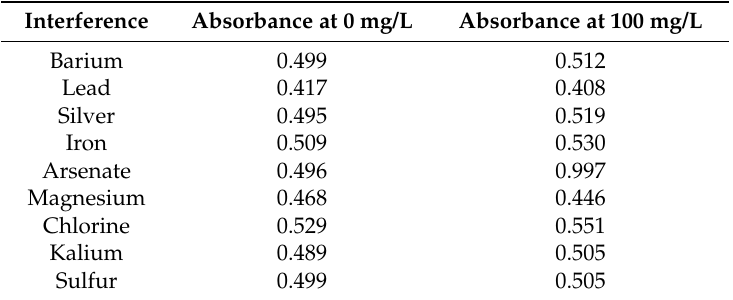
Table 1. The analysis of absorbance variance for different interfering chemicals.